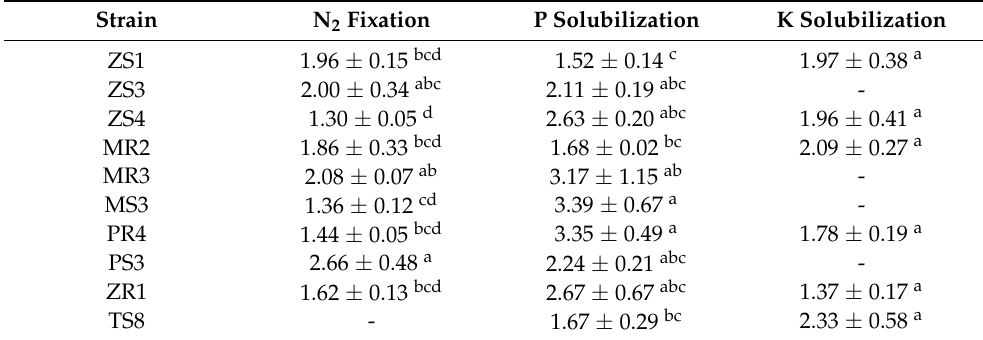
Table 1. N 2 fixation, P solubilization, and K solubilization of screened PGPB. The data are expressed as means ± standard deviation ( n = 3). Different lowercase letters represent significant differences between groups at the 5% level (ANOVA and Tukey’s